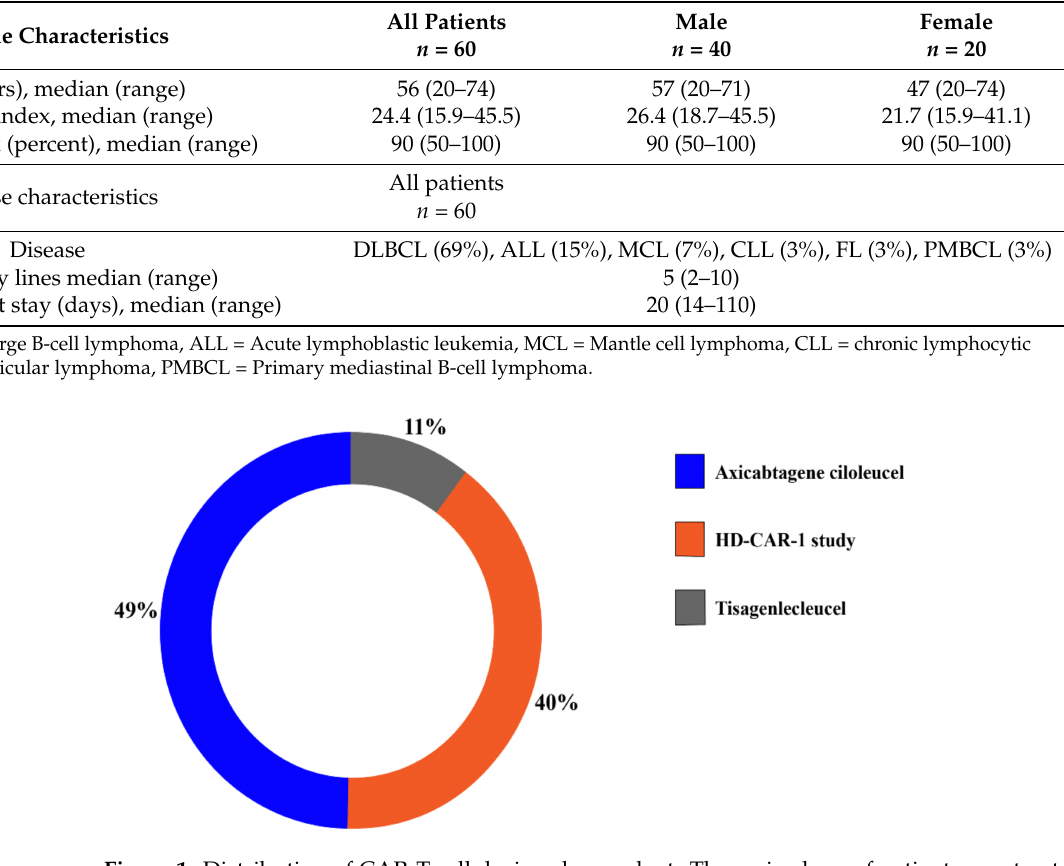
Figure 1. Distribution of CAR-T cell dosings by product. The main share of patients was treated with Axi-Cel ( n = 33, 49%) and as part of the HD-CAR-1 study ( n = 27, 40%). Seven patients received Tisa-Cel